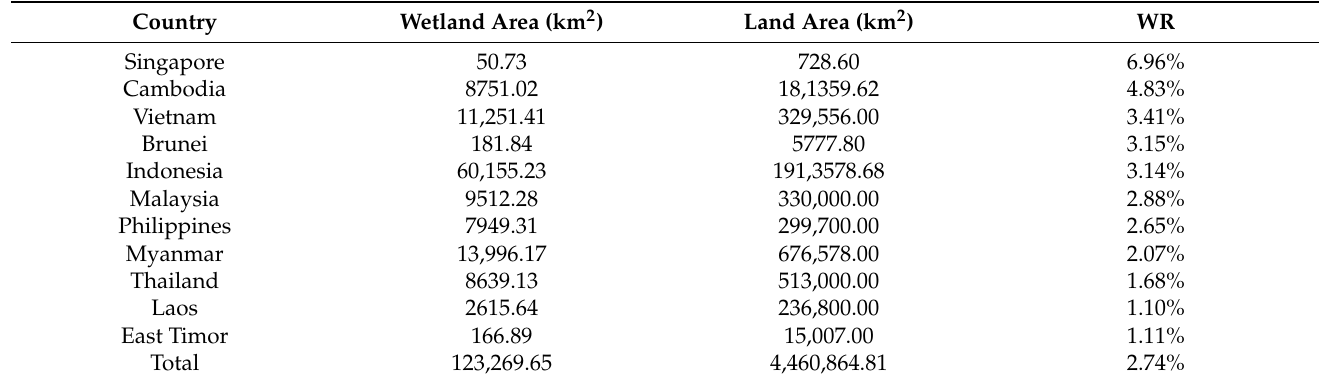
Table 5. The wetland areas in each country of Southeast Asia.